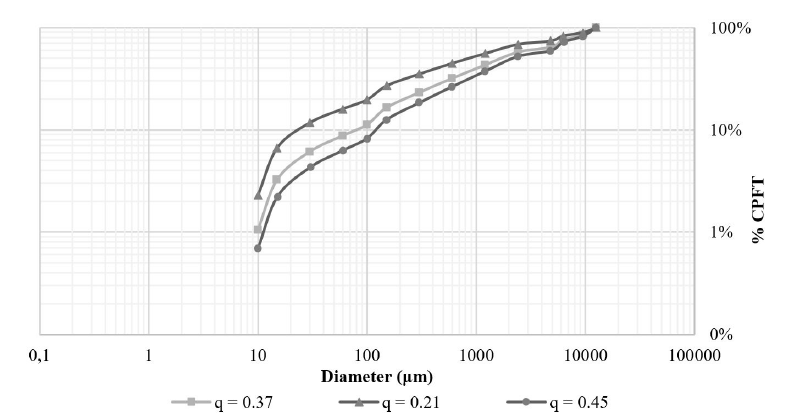
Figure 2. Particle size distribution curve for q = 0.37, q = 0.21 and q =